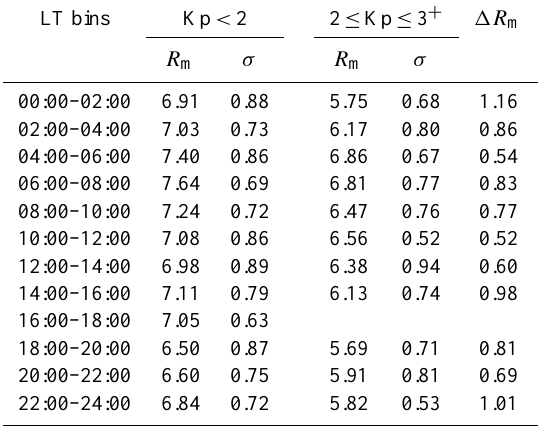
Table 1. The mean ( R m ) and standard deviation ( σ) of radial dis- tances of IBIPS in 12 local time bins during quiet times (Kp < 2) and active times (2 ≤ Kp ≤ 3 + ) . The last column shows the differ- ence between two set of mean radial distances ( 1R m ) (unit: R E ) .